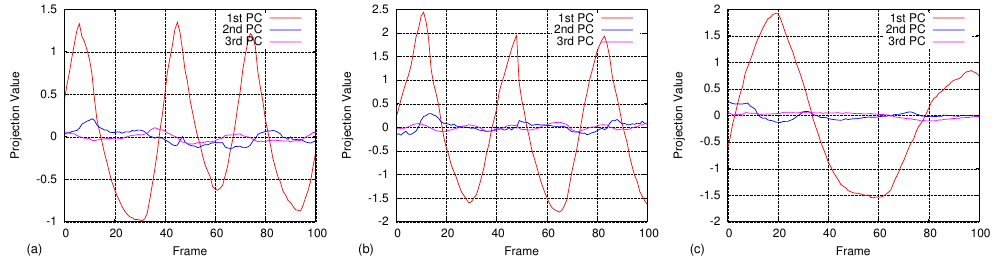
Figure 6. Projection results of 100 depth frames onto the first three PCs. Only the first PC shows a clear respiratory motion pattern for three datasets ( a , b , c ) taken during regular breathing.